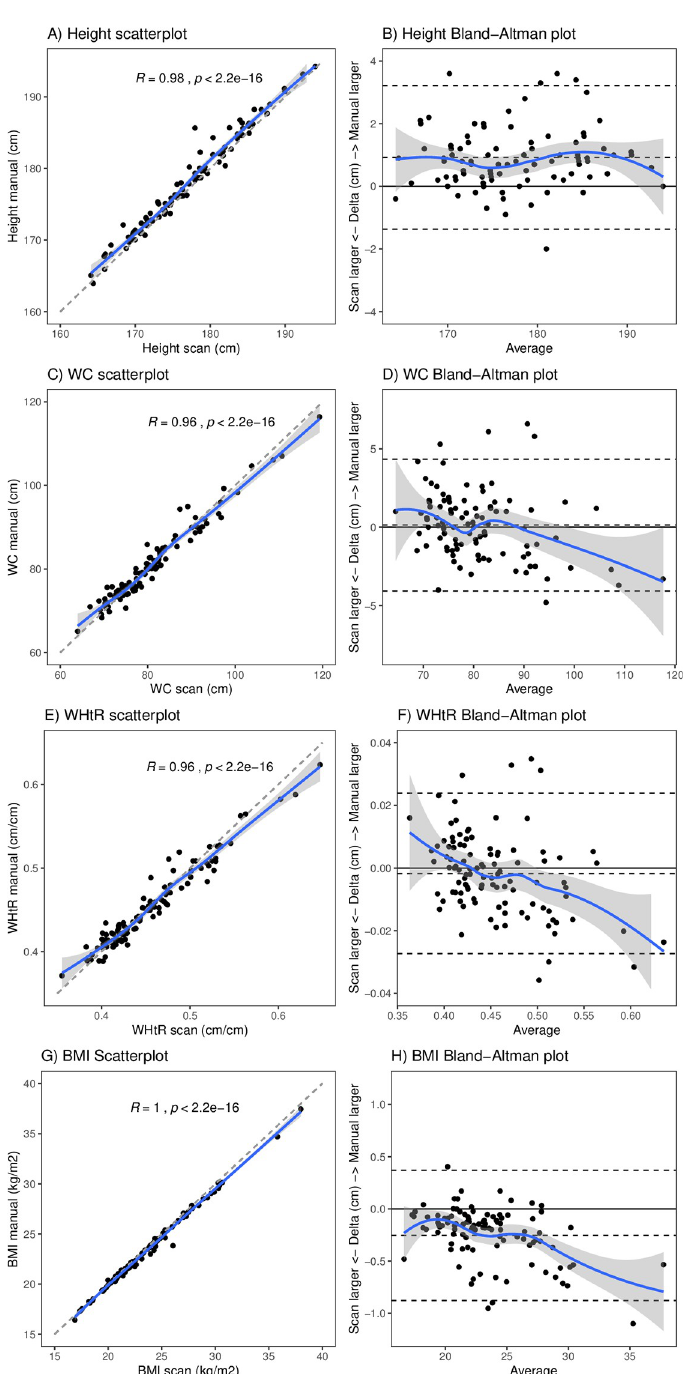
Fig 1. Agreement between methods: Scan vs. manual by scatterplots (left) and Bland Altmann plots (right) for height (A,B), WC (C,D), WHtR (E,F) and BMI (G,H). Generally, scanned and manually measured values are strongly correlated (Spearman Rho > 0.96). For height there is a constant bias of -1cm towards scanned height being shorter. For WC and WHtR there is a trend towards higher values being larger in the in the scanner than when manually